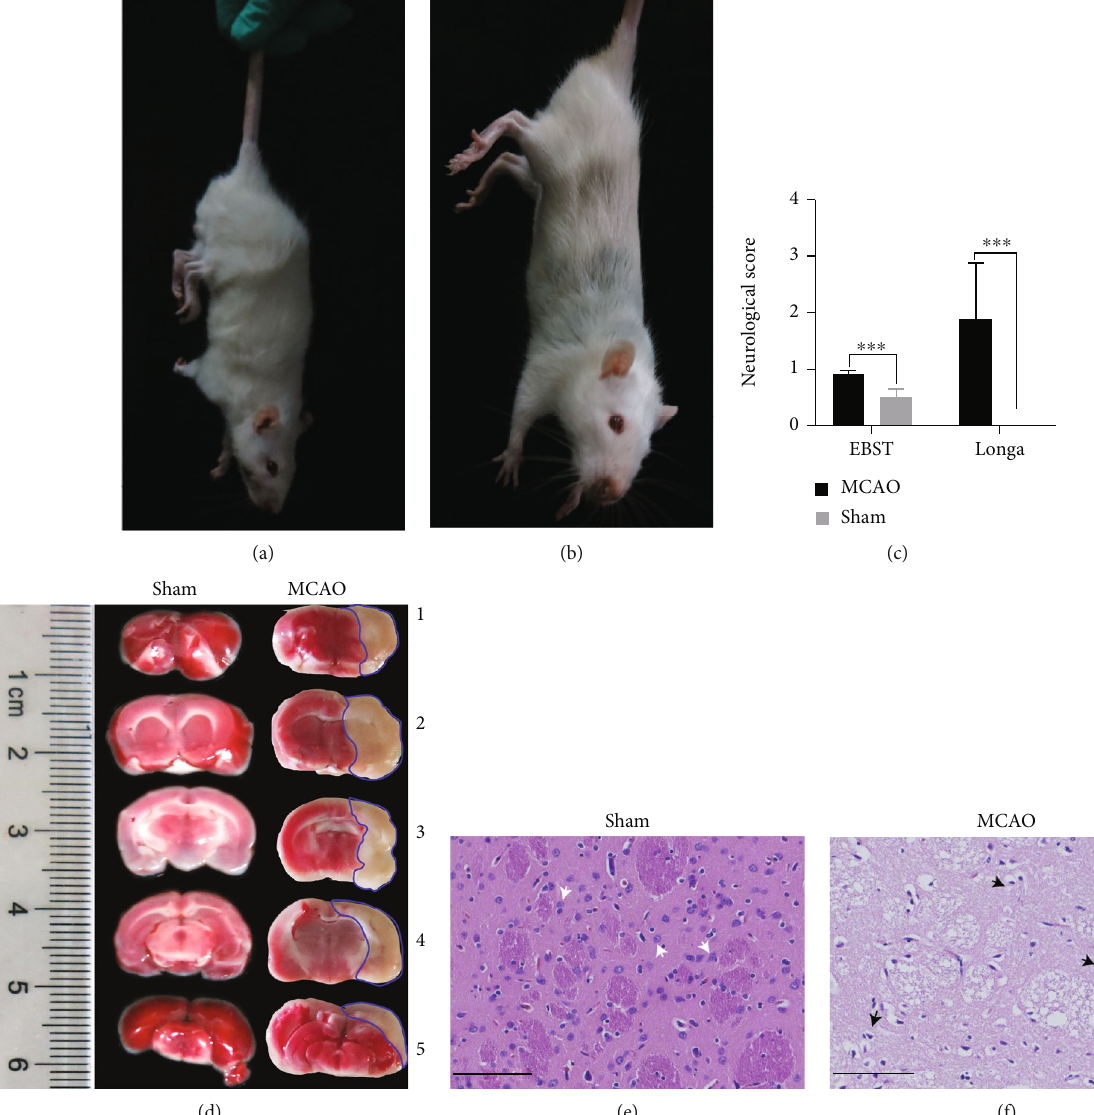
Figure 1: Construction and evaluation of MCAO model for brain injury following ischemia and reperfusion. (a) MCAO rat behavior observations. Longa rating of 1 con fi rmed the success of our MOCA rat model. Behavior manifested as mild neurological de fi cit symptoms, whereby forelimbs could not be fully extended. (b) Sham rat behavior observations. Forelimbs could be naturally extended without neurobehavioral de fi cits. (c) Longa and EBST scores. Data are expressed as the means ± SEMs and compared using Student ’ s t -test ( ∗∗∗ P < 0 : 001 versus sham, n = 5 mice per group with triplicate biological replicates). (d) TTC-stained brain sections. Ischemic area stained white (lined with blue) and the intact area stained red. Left: representative coronal brain sections of the sham group; right: MCAO group at 2h MCAO followed by 24 h of reperfusion. (e, f) H&E-stained brain slices of sham and MCAO groups, respectively ( scale bar = 100 μ m ). Neurons in (e) were tightly aligned with moderate and distinct nucleoli. The white arrows indicate undamaged nerve cells with intact structural morphology. Owing to the presence of vacuolation and mesenchymal edema, staining of the infarcted area was lighter than that of the sham group. The black arrows indicate pathological abnormalities with loosely arranged neurons, pyknotic nuclei, nuclear lysis, and vacuole-like